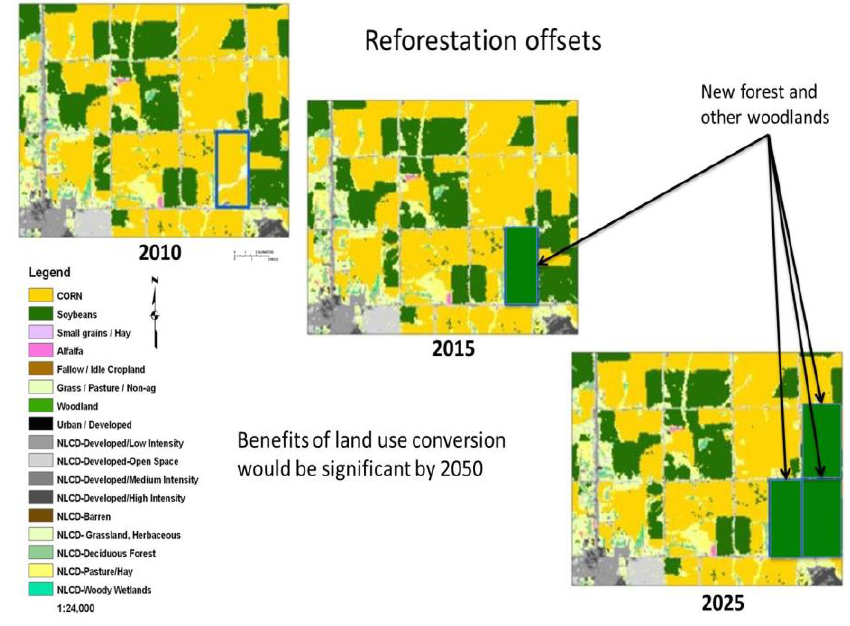
Figure 9. An ecosystem services market with land-use offsets that uses remote sensing